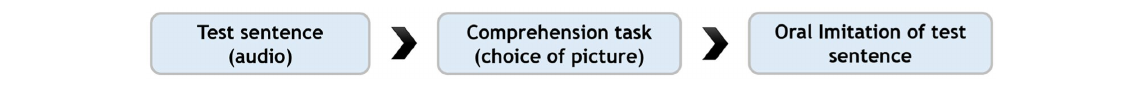
FIGURE 1 Experimental procedures of Elicited Oral Imitation